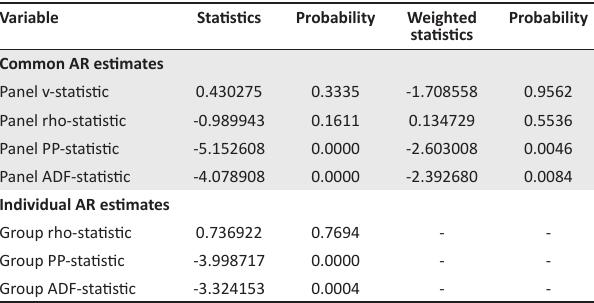
TABLE 3: Pedroni cointegration test results.